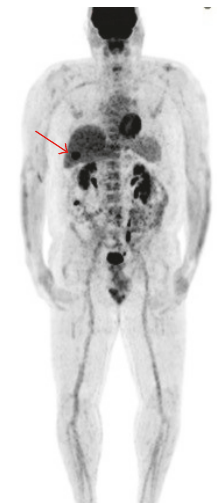
Figure 3: Whole body MIP image showing abnormal focal activity in the region of the gallbladder (red